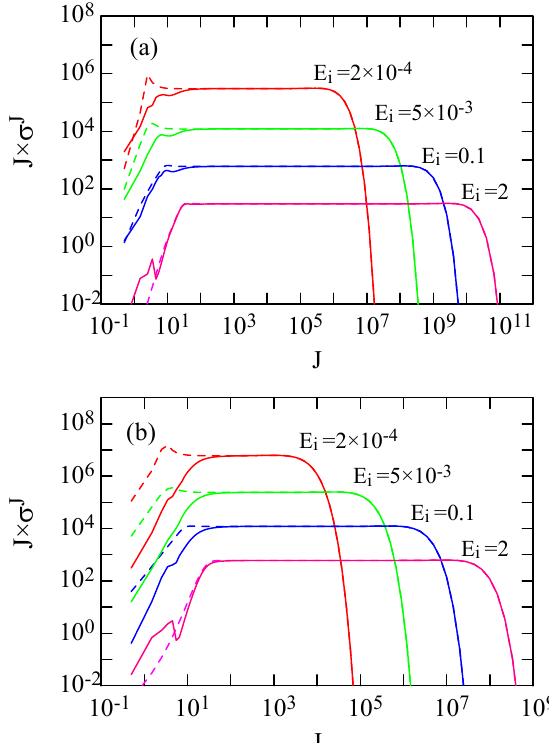
Figure 4. Variation of J × σ J with partial waves J for ( a ) 4f 5/2 –4d 5/2 and ( b ) 4d 5/2 –4f 7/2 transitions. Broken curves: Born and continuous curves: CC + Born results. Energies are in